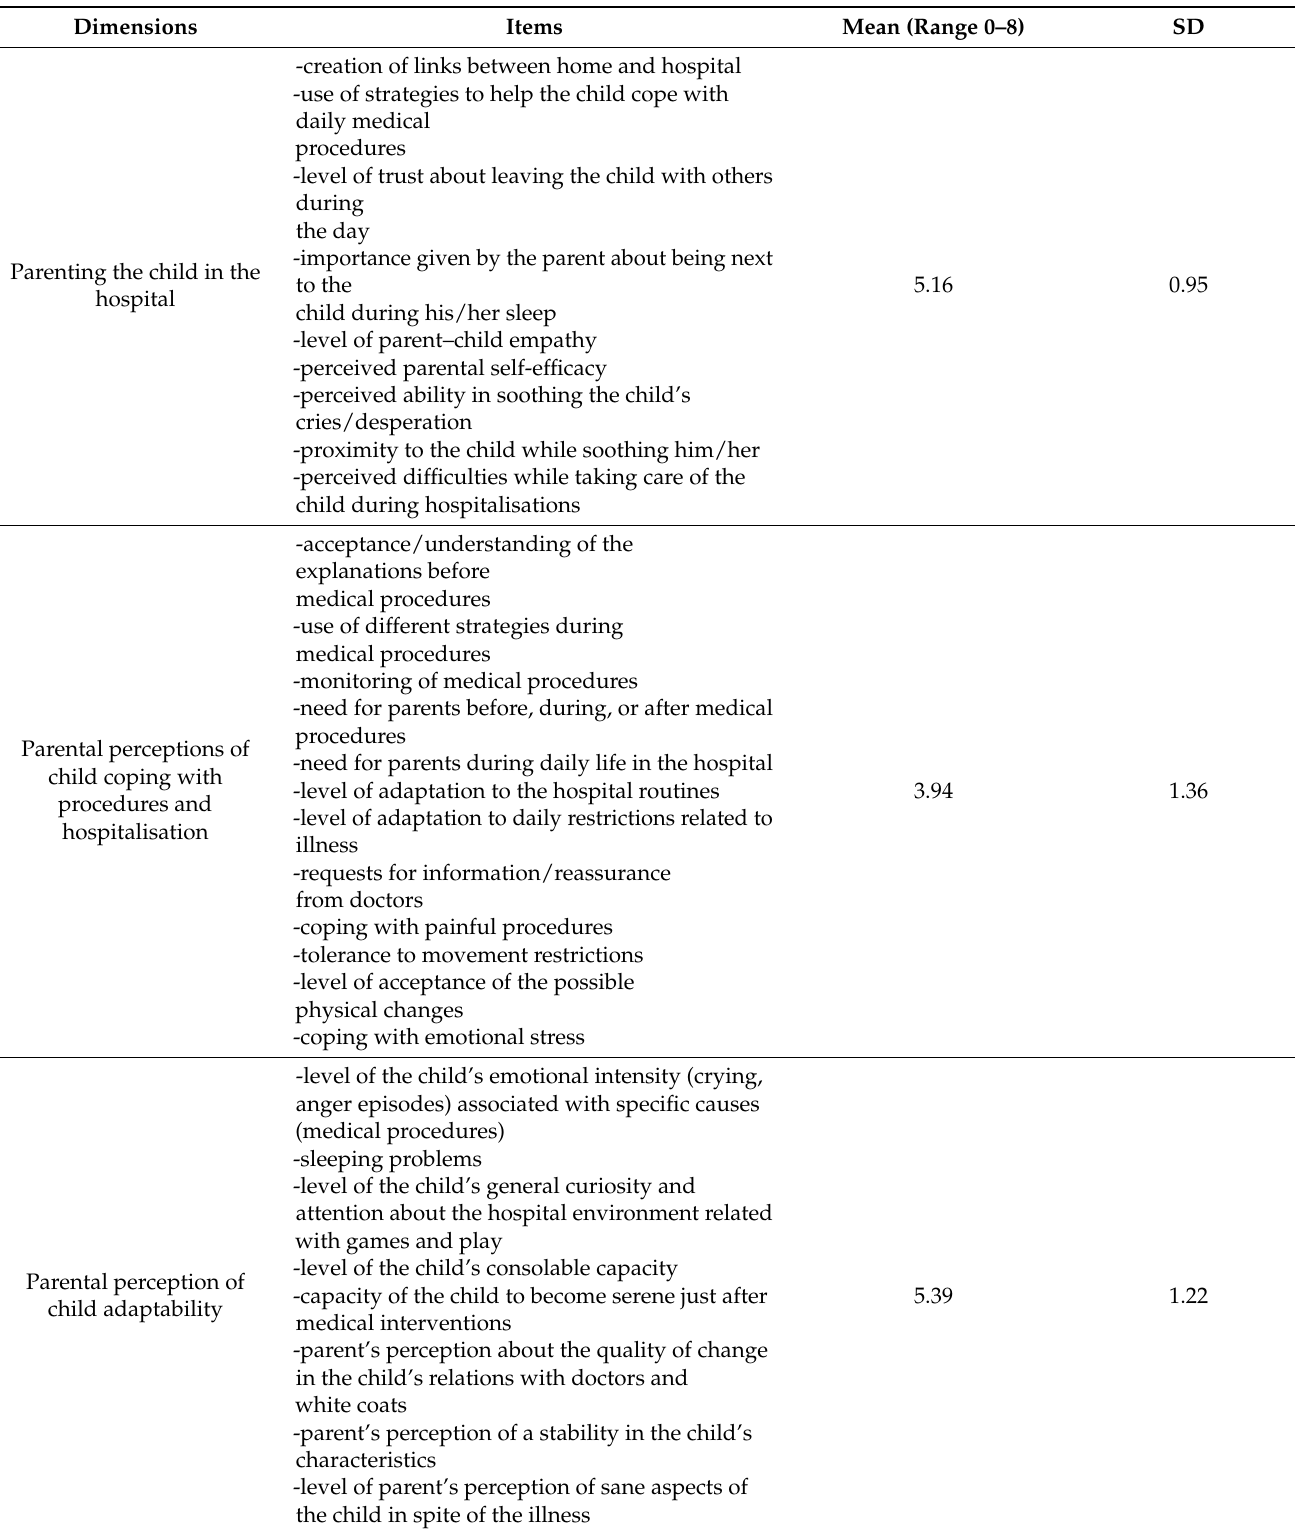
Table 1. EFI-C child and parent dimensions and relative descriptive statistics considered in the present study.